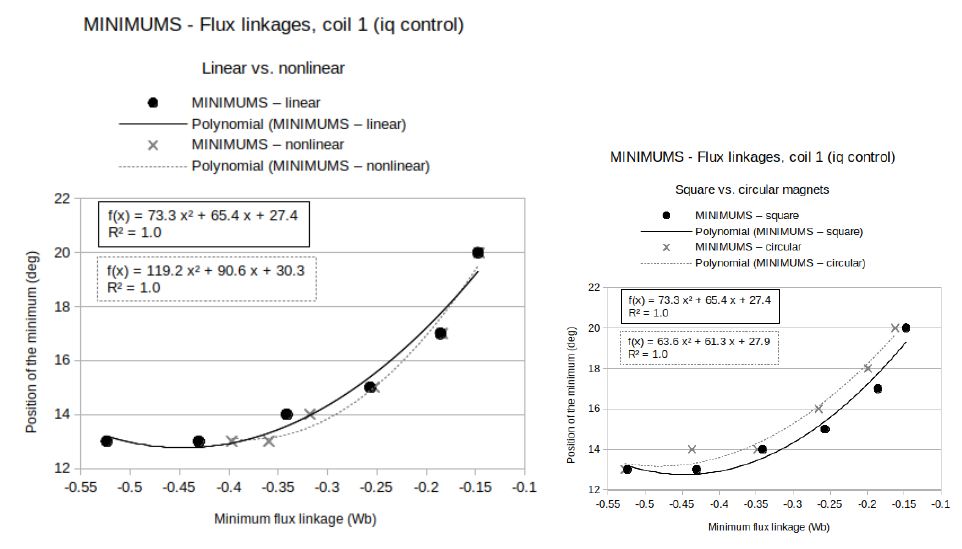
Figure 14. Changes of the position of the minimum flux